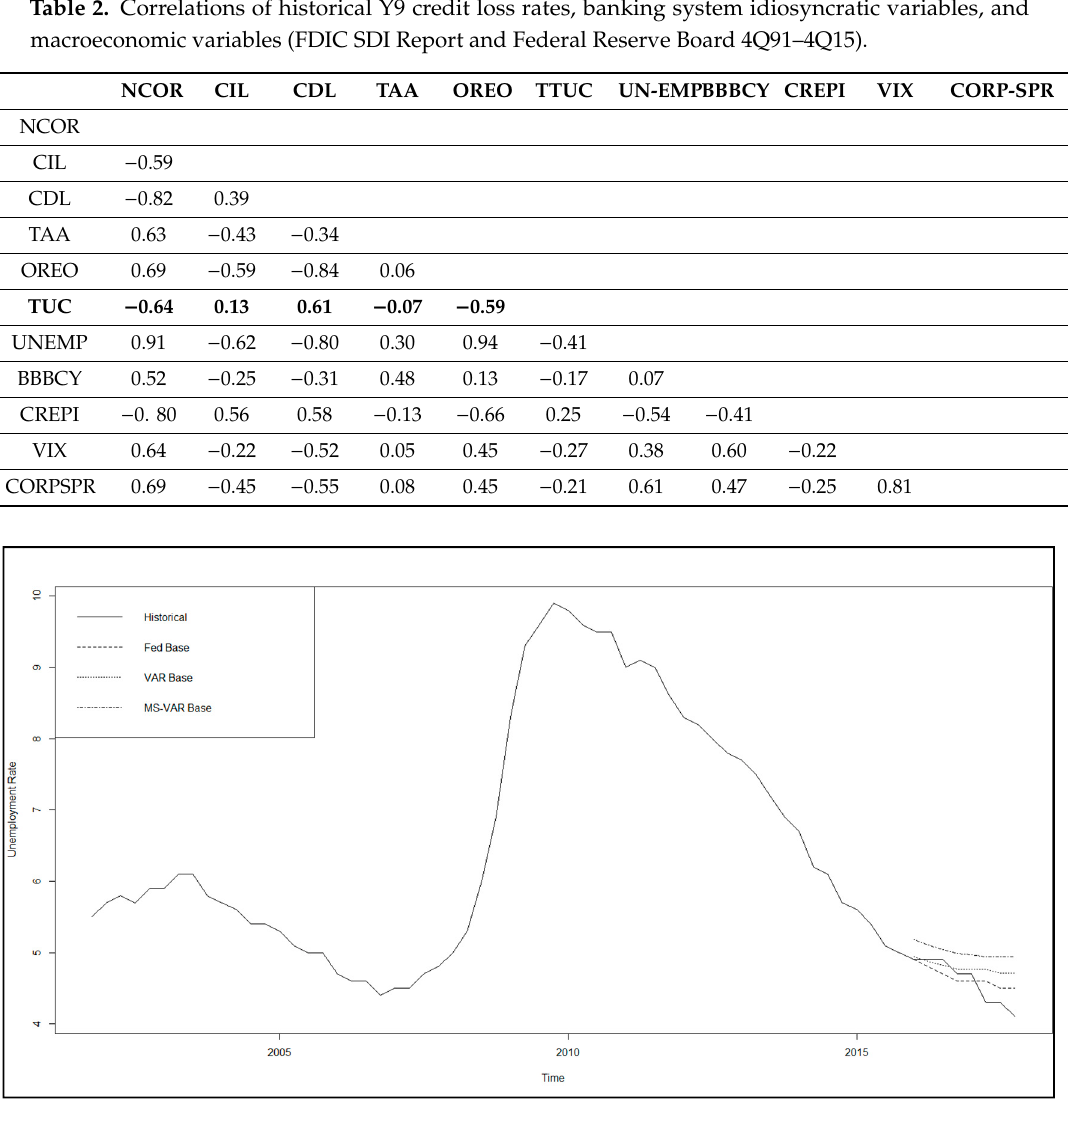
Figure 6. Time series and base scenarios—commercial and industrial loans to total assets (Federal Deposit Insurance Corporation (FDIC) Statistics on Depository Institutions (SDI) Report, Federal Reserve Board 4Q91–4Q15 and Jacobs (2018) models). Considering the correlations within and across the sets of macroeconomic and idiosyncratic variables, we note that signs are all economically intuitive, and, while magnitudes are material, they are not high enough to result in concerns of multicollinearity. A critical modeling consideration for the MS-VAR estimation is the choice of process generation distributions for the normal and the stressed regimes. As described in the summary statistics of Jacobs (2018), we find that, when analyzing the macroeconomic data in percentage change form, there is considerable skewness in the direction of adverse changes (i.e., right skewness for variables where increases denote deteriorating economic conditions such as UNEMP). Furthermore, in normal regimes, where percentage changes are small, we find a normal distribution to adequately describe the error distribution, whereas, when such changes are at extreme levels in the adverse direction, we